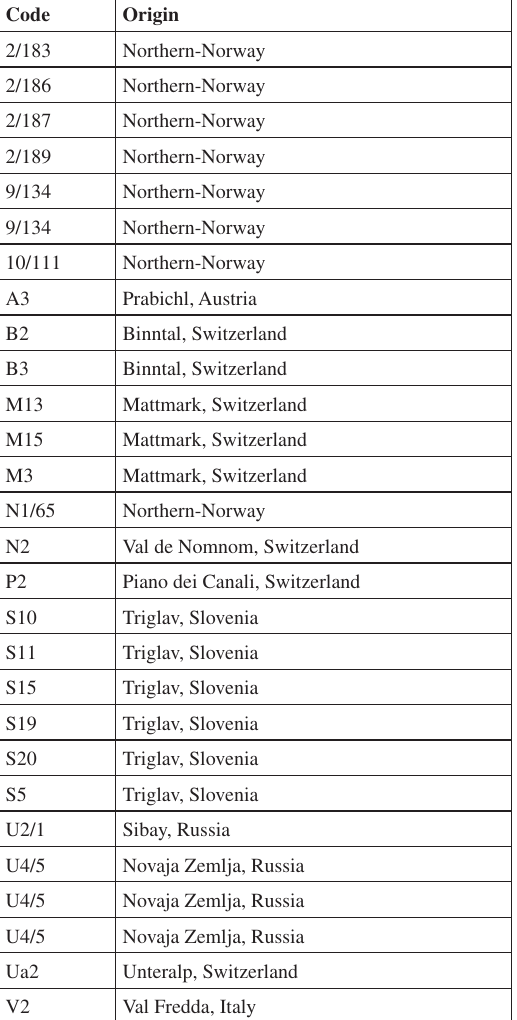
Table 1. Plant material